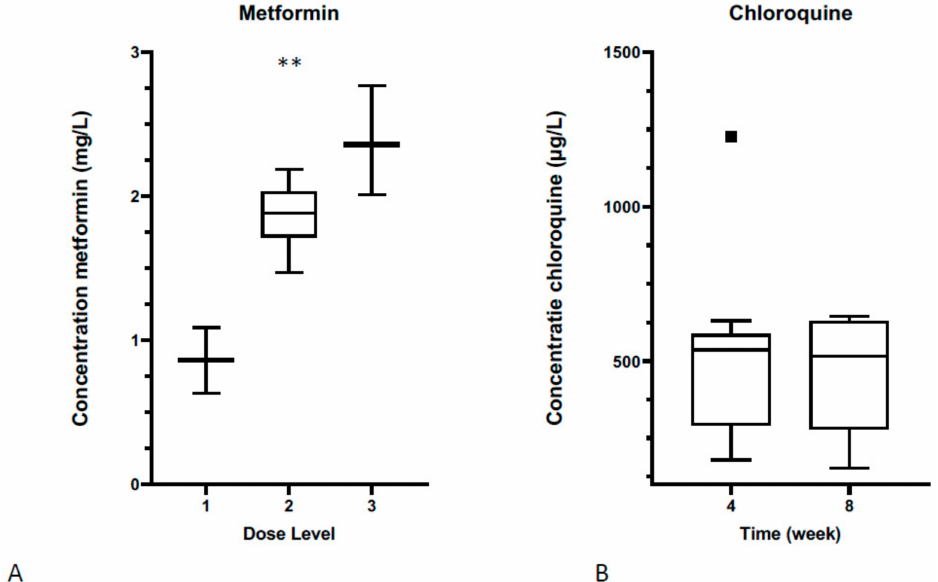
Figure 2. Serum concentrations of metformin and chloroquine. ( A ) A dose level-dependent increase of the plasma metformin concentration is shown; (** p < 0.01, one-way ANOVA test). ( B ) Non- escalating chloroquine doses in time, resulting in stable plasma concentrations at subsequent time